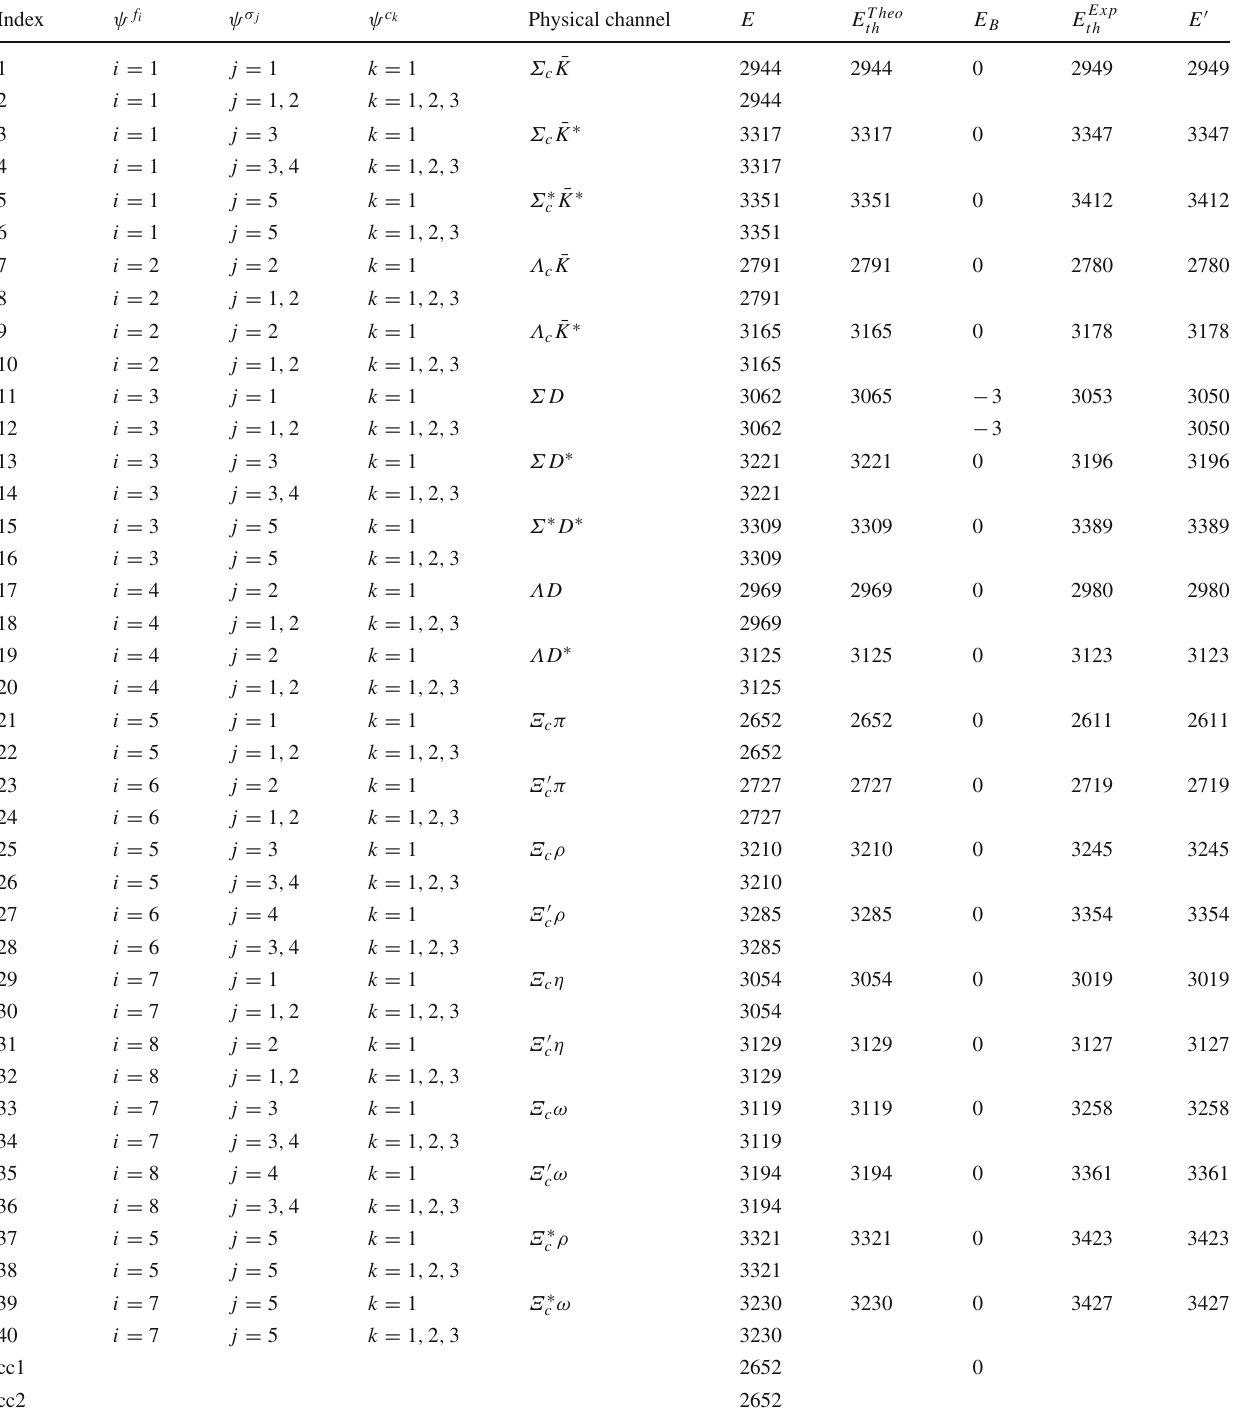
− 1 . “cc1” denotes the color-singlet channels coupling and “cc2” means full channels 2 2